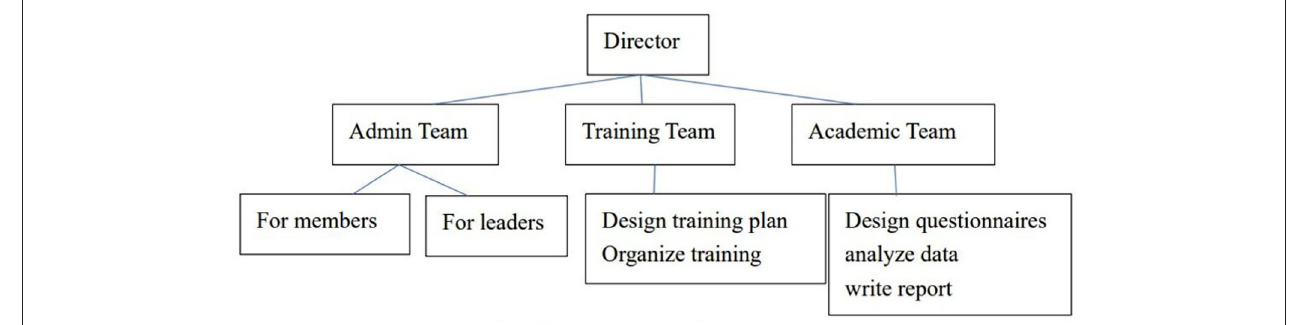
FIGURE 2 | Staff team